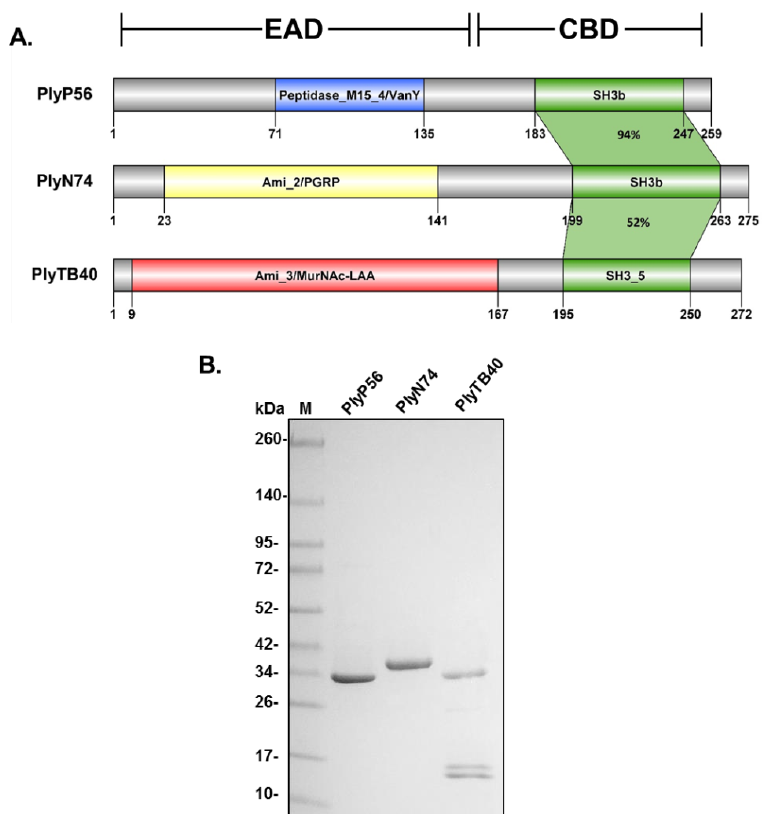
Figure 2. Bacillus bacteriophage endolysin structural characterization and protein profile. ( A ) PlyP56, PlyN74, and PlyTB40 contain divergent N-terminal enzymatic active domains (EADs) and conserved C-terminal cell wall binding domains (CBDs). PlyP56 has a Peptidase_M15_4 EAD domain found within the VanY superfamily. PlyN74 has an Amidase_2 EAD domain that is part of the MurNAc-LAA superfamily. PlyTB40 has an Amidase_3 EAD that is also part of the MurNAc-LAA superfamily but lacks homology with the Amidase_2 domain of PlyN74. All three endolysins have similar SH3-family binding domains. Color coding of EADs correspond to Figure 1. ( B ) Purification of Bacillus phage endolysins. E. coli BL21-(DE3) cells were transformed with a vector encoding recombinant endolysins, grown, and induced with L -arabinose as described under Methods. The recombinant endolysins were purified to homogeneity by nickel affinity chromatography. Protein samples were analyzed for purity by SDS-PAGE with Coomassie blue staining. Lane 1, molecular mass markers as indicated; Lane 2, PlyP56; Lane 3, PlyN74; Lane 4, PlyTB40.